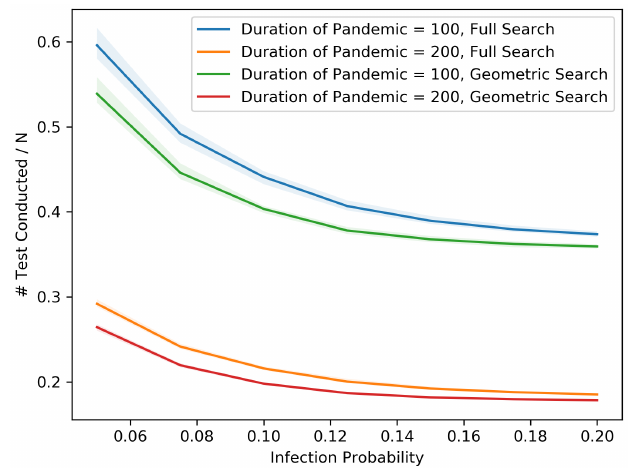
Figure 8. Number of Tests. Population = 1,000,000 Non-cooperative Rate = 0.333. N: number of people inside and containing the external boundary.